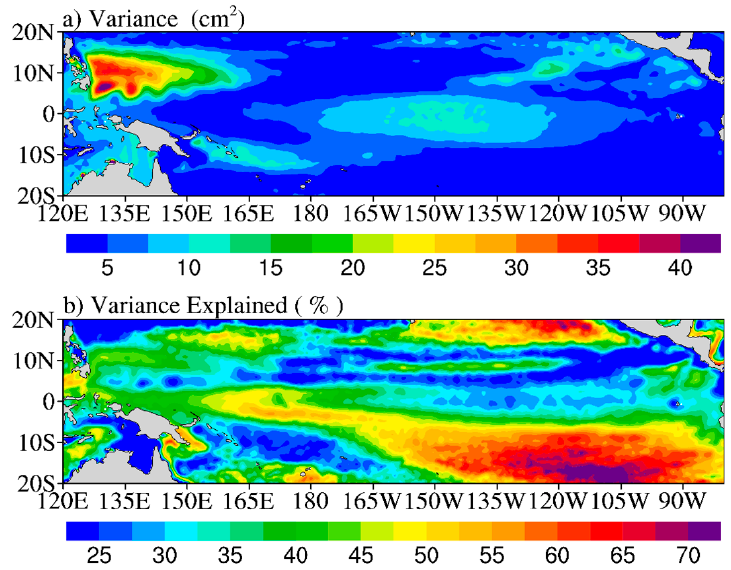
Figure 8. ( a ) The decadal sea level variances and ( b ) explained variances in the TPO.